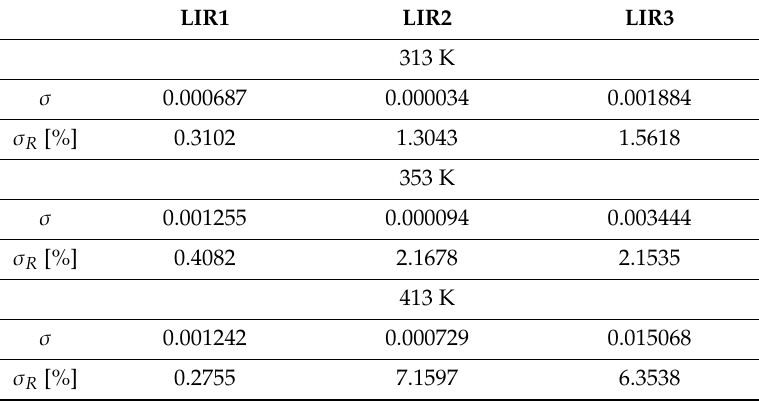
Table 2. Uncertainties in LIRs at di ff erent temperatures; σ —the standard deviation of measurement, σ R —the relative standard deviation of